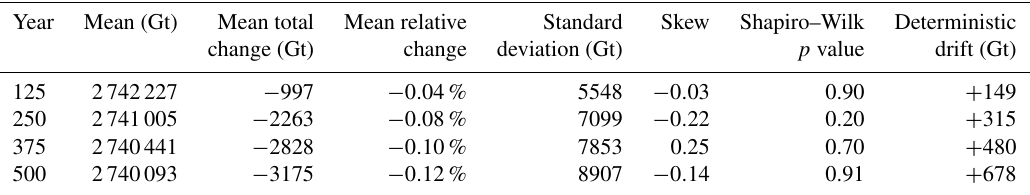
Figure 7. Left: change in ice mass throughout the transient experiments for each ensemble member in the four IQIS ensembles. In labels, variables between brackets denote variables with stochastic variability imposed (Table 1). Thick lines show the ensemble means. The right y axis shows change relative to the initial ice mass. Right: corresponding PDFs of the ice mass change after 50, 150, 300, and 500 years of simulations. Table 6. Statistics of the ice mass distributions of the GrIS ensemble after 125, 250, 375, and 500 years of simulation. The relative change and deterministic drift are calculated with respect to the initial ice mass